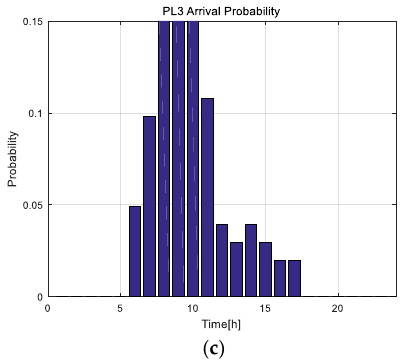
Figure 7. The Probability of Arrival at the Parking Lot ( a ) PL1, ( b ) PL2, ( c ) PL3.